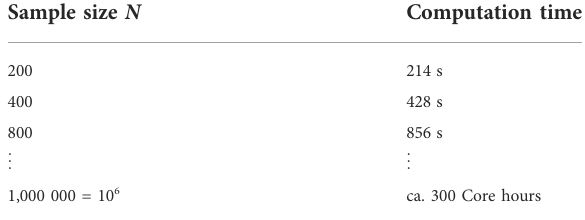
TABLE 2 Computation time for different training sample sizes N . The fi rst 3 N represent the computation time with the presented GAM procedure and the last row N represent the order of magnitude of the computation time needed for MCMC sampling on a whole brain section.